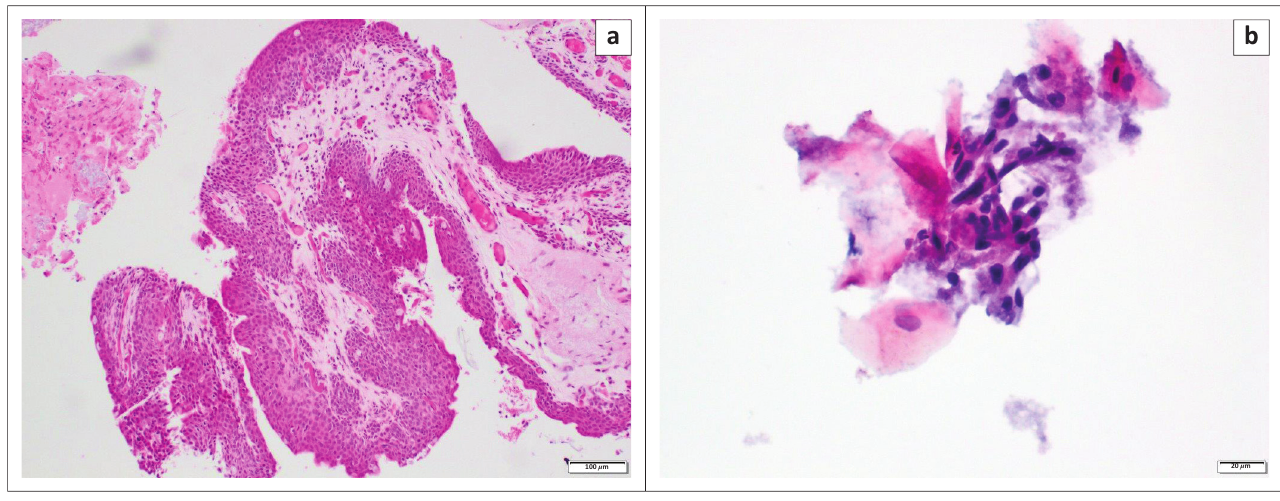
FIGURE 1 (Continues...) : (a and b) Anterior segment photograph and anterior segment-optical coherence tomography of a leucoplakic lesion with feeder vessels. Anterior segment-optical coherence tomography (b) showing the transition zone (white arrow) with thickened hyper-reflective epithelium. The leucoplakia has caused shadowing that has masked the demarcation line (white asterisk). (c–e) Anterior segment photographs and anterior segment-optical coherence tomography of a gelatinous lesion. Anterior segment-optical coherence tomography (d) showing the transition zone (white arrow), thickened hyper-reflective epithelium and demarcation line (yellow arrows). (e) The methylene blue stain highlights the extent of the lesion (black dotted line) that is not clinically obvious on slit lamp examination. (f–h) Anterior segment photos and anterior segment-optical coherence tomography of a leucoplakic lesion. The anterior segment-optical coherence tomography (g) shows classic features of ocular surface squamous neoplasia. The methylene blue stain (h) delineates the margins of the lesion.